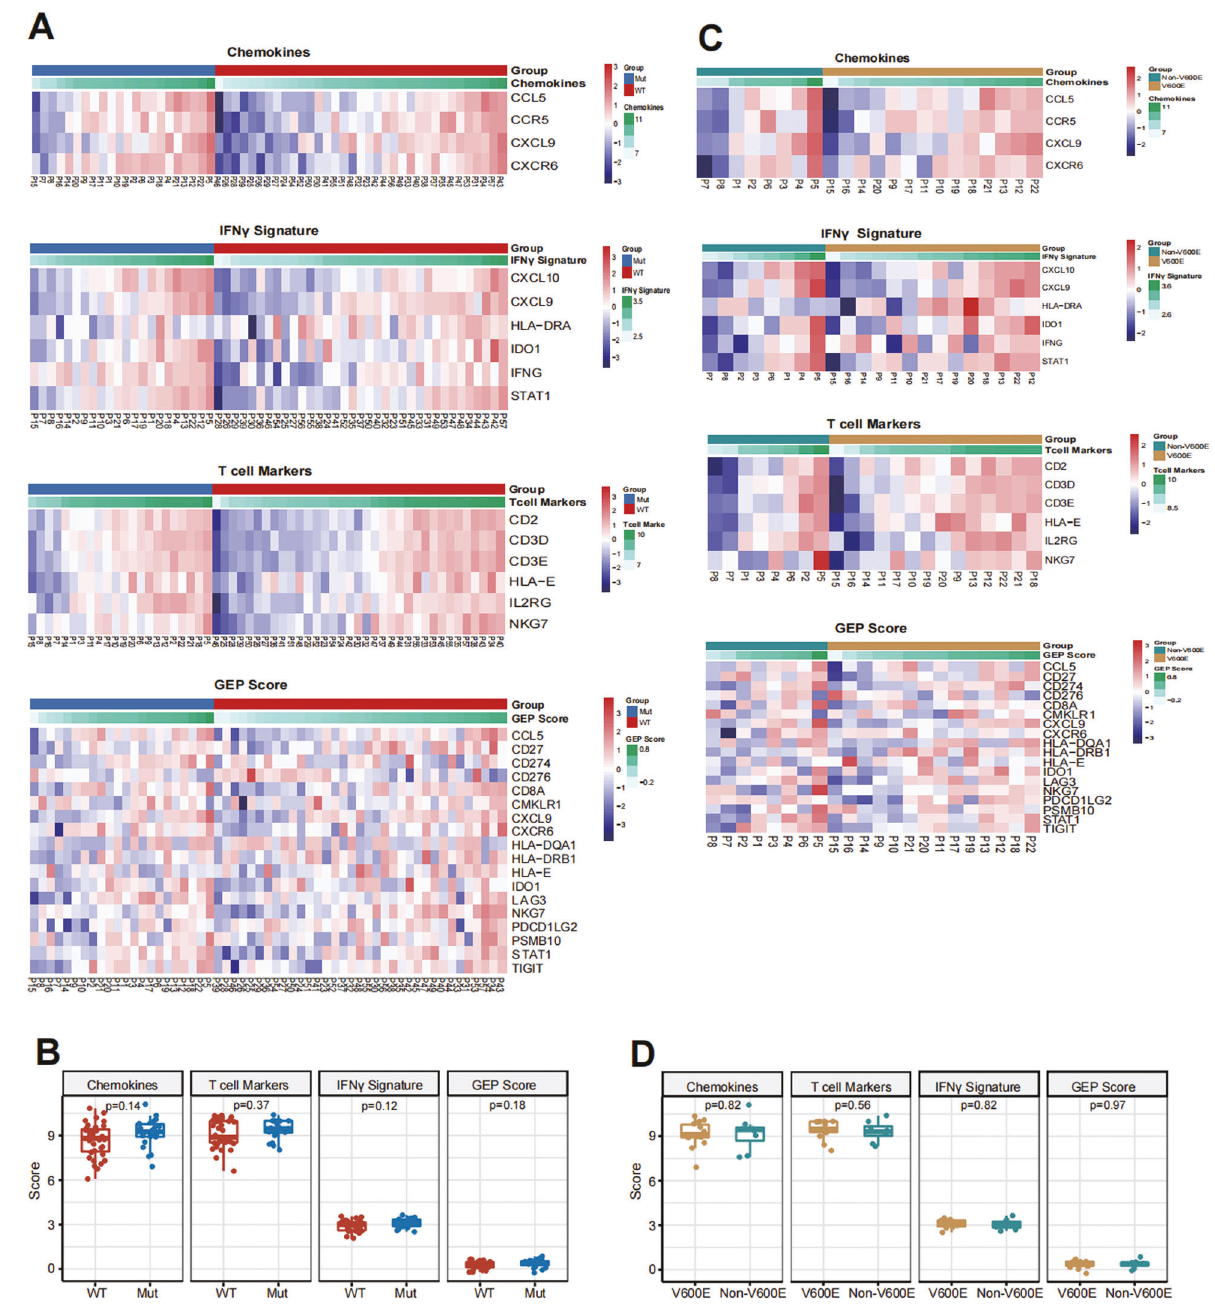
Fig. 4 The effect of BRAF mutation on different immune signature in NSCLC. A Heatmap analysis of gene transcripts related to immune signatures in the WT and BRAF mutated NSCLC specimens. B Quantitative analysis of immune signatures in the WT and BRAF mutated NSCLC specimens. C Heatmap analysis of gene transcripts related to immune signatures in the BRAF V600E and Non-V600E NSCLC specimens. D Quantitative analysis of immune signatures in the BRAF V600E and Non-V600E NSCLC